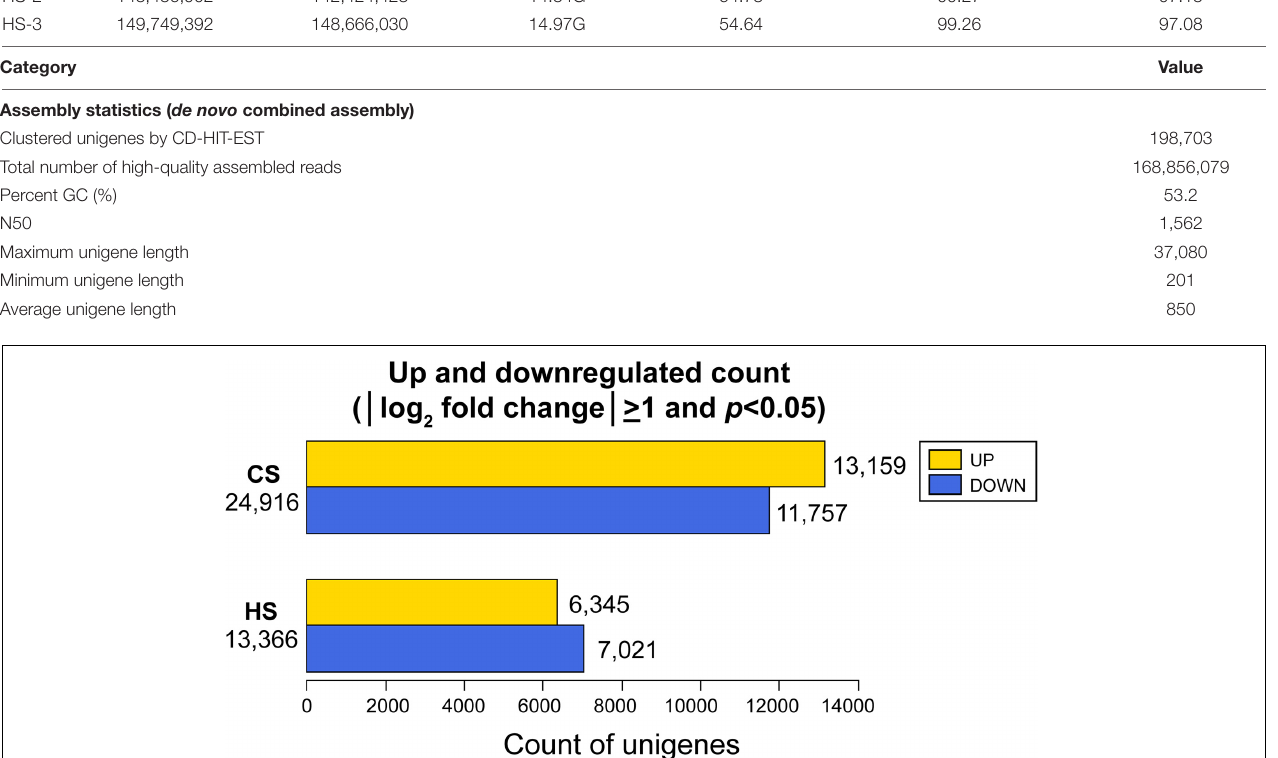
FIGURE 3 | Upregulated and downregulated unigenes obtained with |log 2 fold change| ≥ 1 and p < 0.05 under cold stress (CS) and heat stress (HS) against optimal temperature.